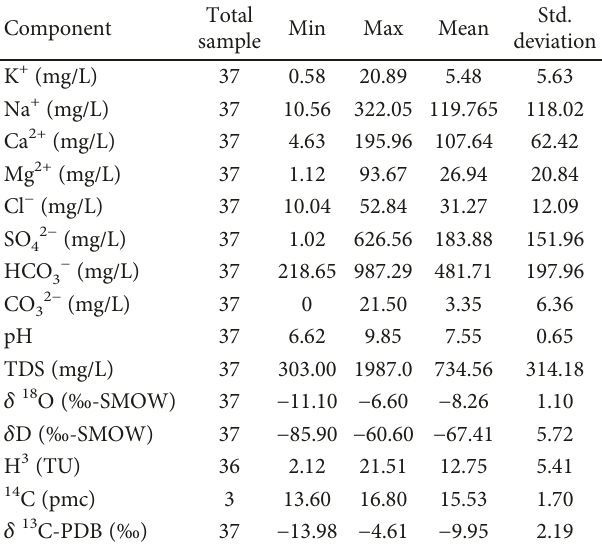
Table 2: Chemical composition descriptive statistics of water samples in the study